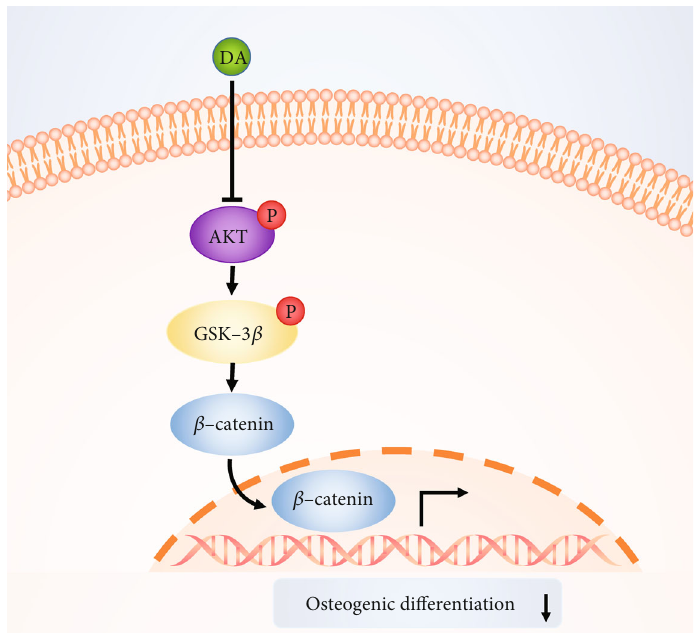
Figure 7: Schematic diagram of DA-mediated osteogenic di ff erentiation by modulating AKT/GSK-3 β / β -catenin pathway in rBMSCs. Intracellular p-AKT and p-GSK-3 β level was downregulated by DA. Subsequently, translocation of β -catenin from the cytoplasm to the nucleus was suppressed, resulting in the inhibition of osteogenic di ff